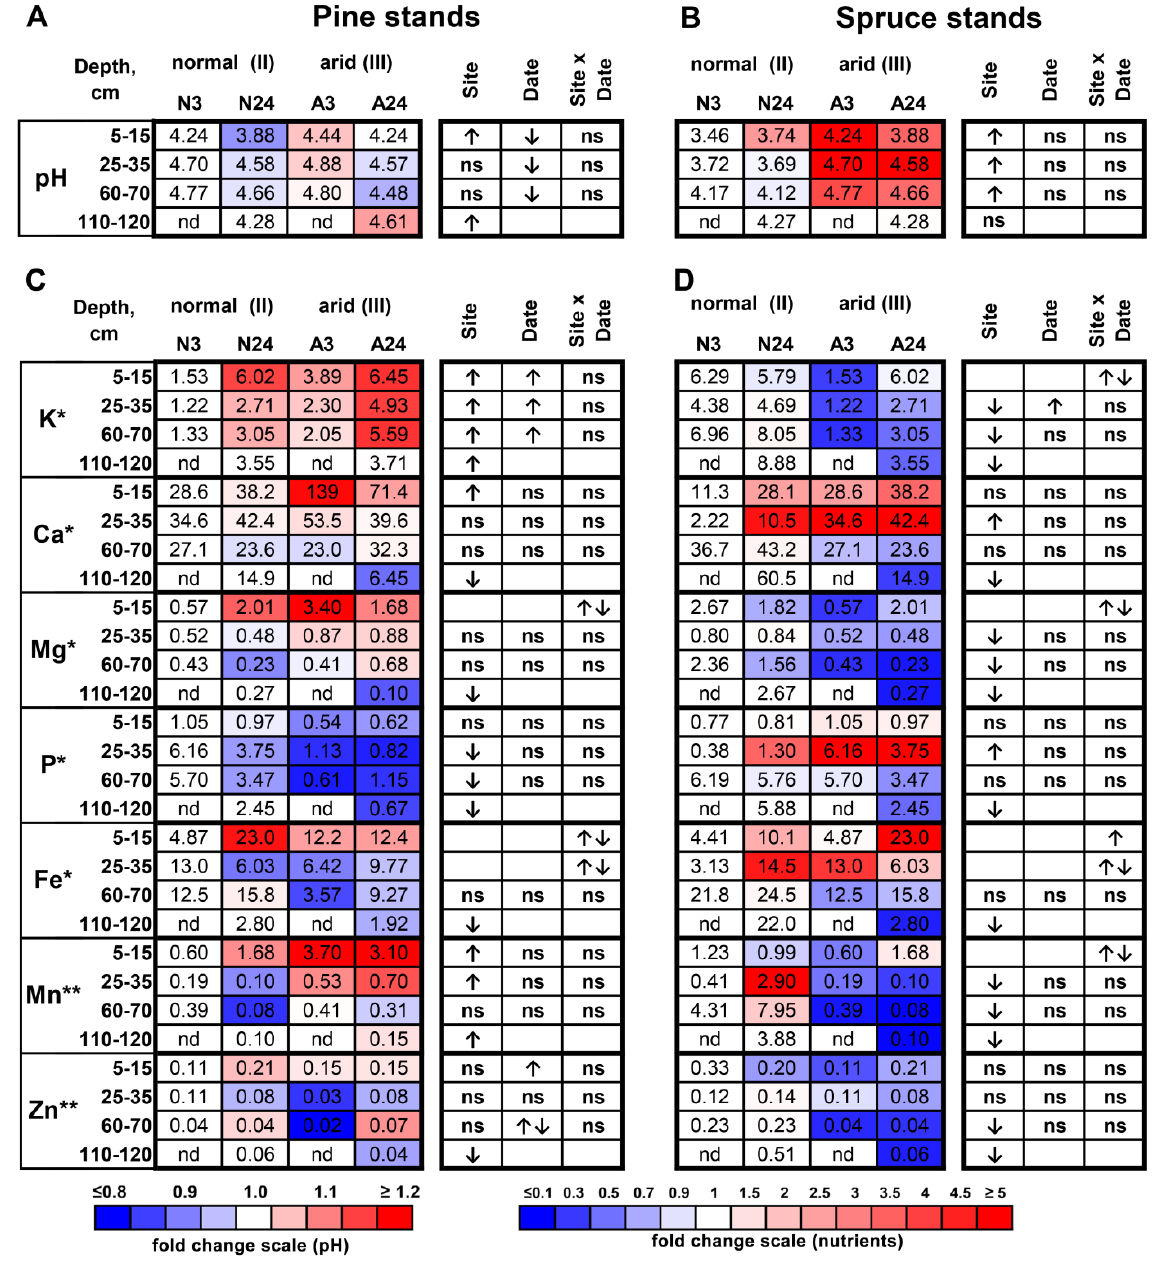
Figure 1. pH ( A,B ) and contents of nutrients ( C,D ) at 4 depths (I—5–15 cm, II—25–35 cm, III—60–70 cm, and IV—110–120 cm) for pine-inhabited Site III (arid) and Site II (normal) ( A,C ) and for spruce-inhabited Site II (arid) and Site I (normal) ( B, D ). The contents of the elements on 3rd August in the normal plot were taken as 1.0 (white), the relative increase is indicated by red, and the relative decrease is indicated by blue; numbers indicate mean element contents in mg/kg DW (* and **). The significance of the site, sampling date, and site × date interaction were calculated using two-way ANOVA ( p < 0.05), with an upwards arrow indicating positive influence, a downwards arrow indicating negative influence, double arrows indicating differently directed influence, and “ns” indicating no significant influence.